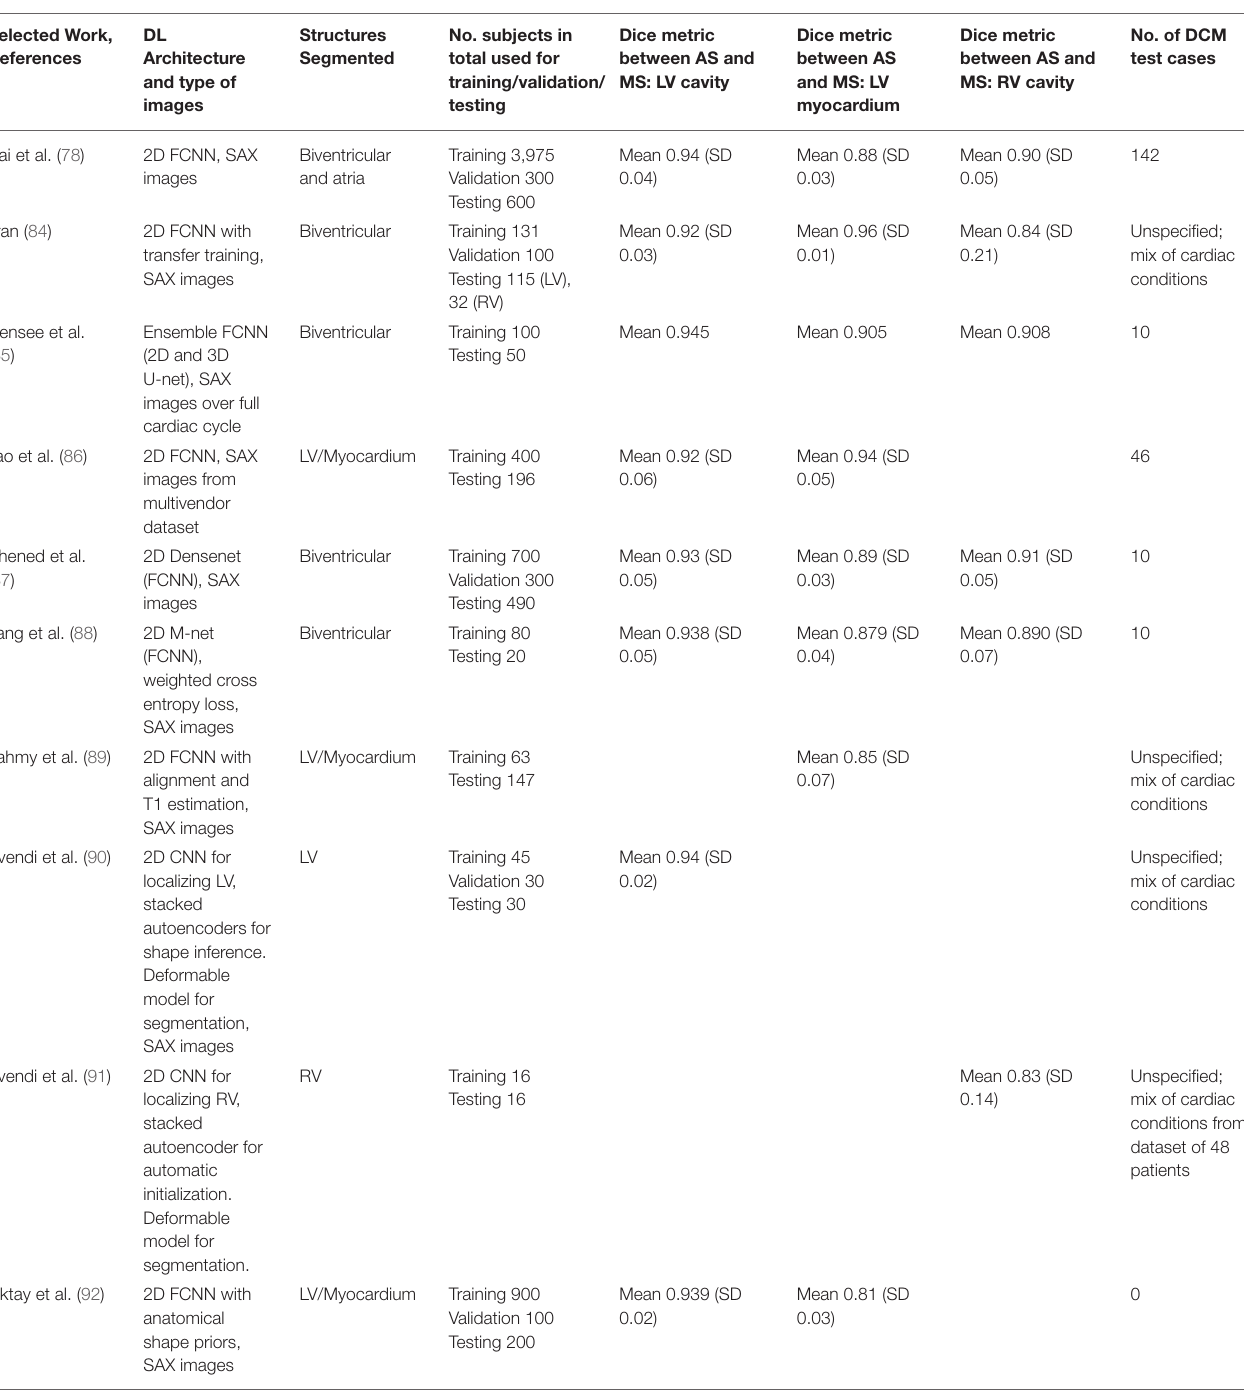
TABLE 2 | State of the art DL architecture on CMR datasets and number of DCM cases encountered in test datasets. Selected Work,